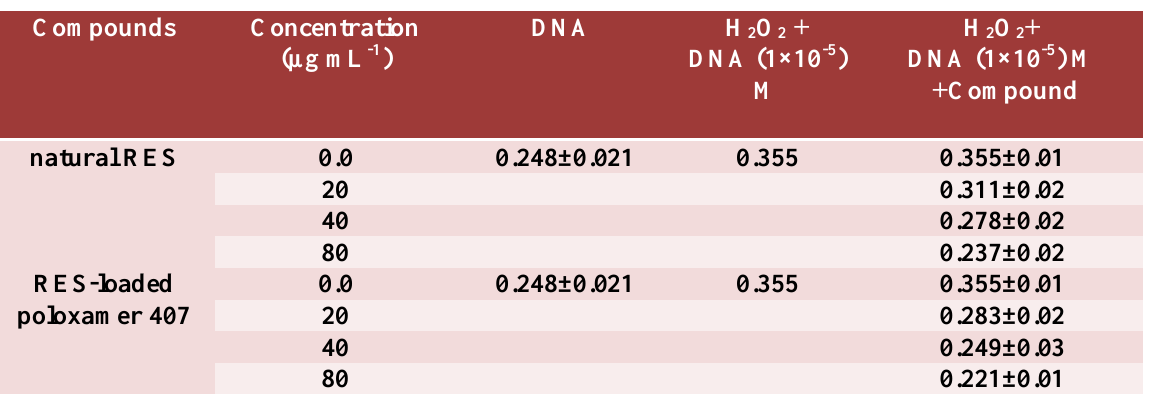
Table 1: The influence of natural RES and RES-loaded poloxamer 407 on the DNA molecule and its preservation from the effect of oxidation